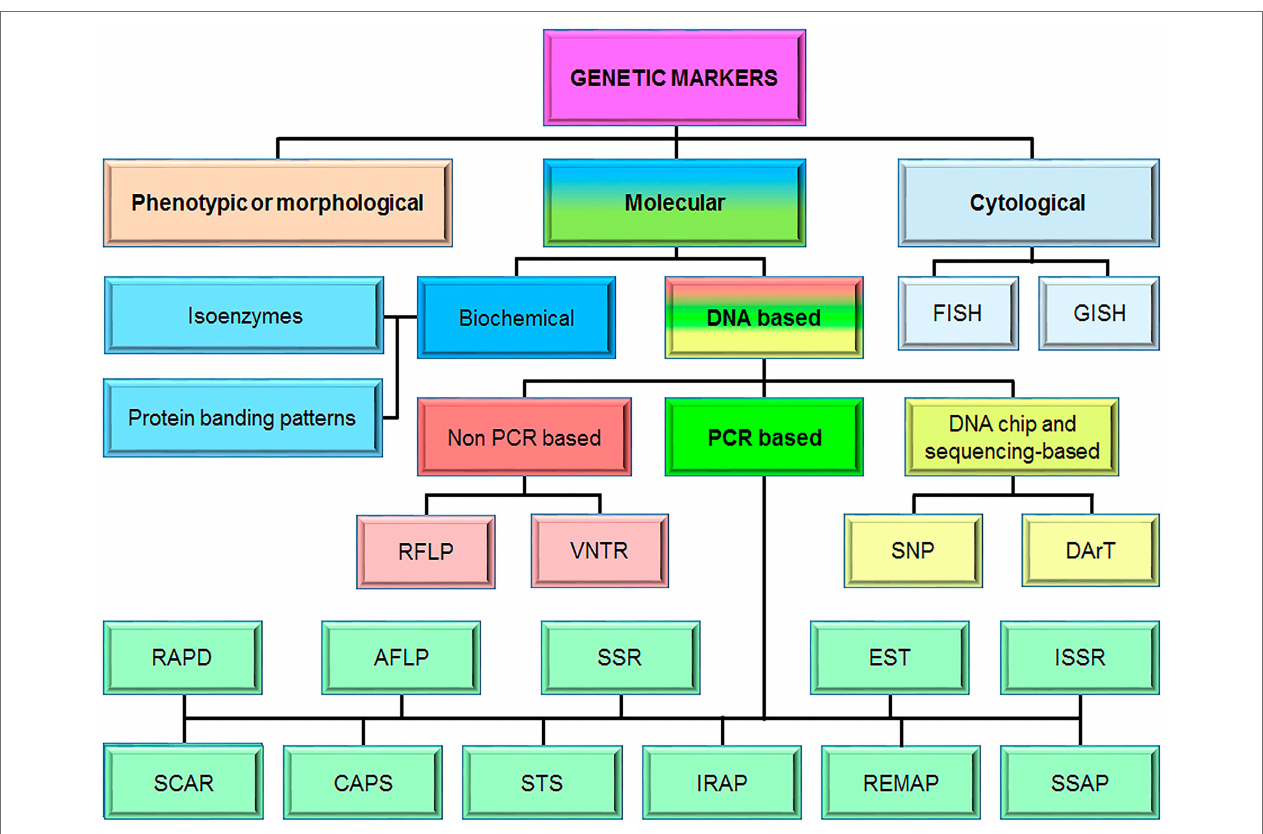
FIGURE 1 | The classification of genetic markers. FISH, fluorescence in situ hybridization; GISH, genome in situ hybridization, RFLP, restriction fragment length polymorphism; VNTR, variable number tandem repeat; SNP, single-nucleotide polymorphism; DArT, diversity arrays technology; RAPD, random amplified polymorphic DNA; AFLP, amplified fragment length polymorphism; SSRs, simple-sequence repeats; EST, expressed sequence tag; ISSR, inter simple-sequence repeat; SCAR, sequence-characterized amplified region; CAPS, cleaved amplified polymorphic sequences; STS, sequence-tagged sites; IRAP, inter-retrotransposon amplified polymorphism; REMAP, retrotransposon-microsatellite amplified polymorphism, and SSAPs, sequence-specific amplification